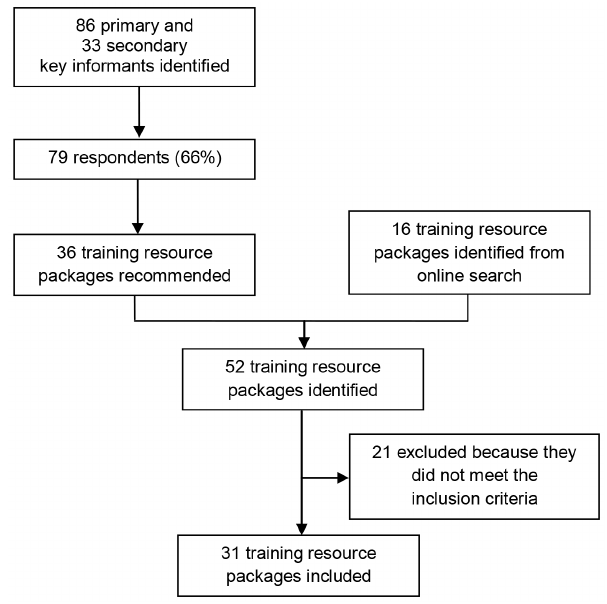
Figure 1. Search strategy.